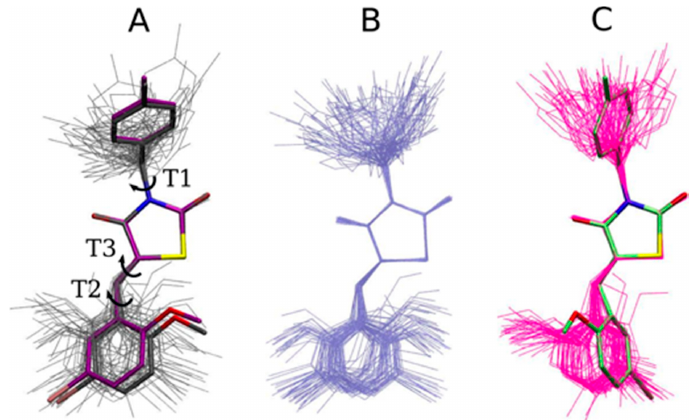
Figure 6. ( A ) Minimized GQ16 structures: QM (carbon atoms in gray) and MM (carbon atoms in purple) superposed with molecular snapshots from the GQ16 MD trajectory in vacuum (thin gray lines), aligning the central ring; ( B ) molecular snapshots of GQ16 MD simulations in water (thin light blue lines) and ( C ) molecular snapshots of GQ16 MD simulations in PPAR γ LBD (thin magenta lines) superposed with crystallographic structure (carbon atoms in lime).